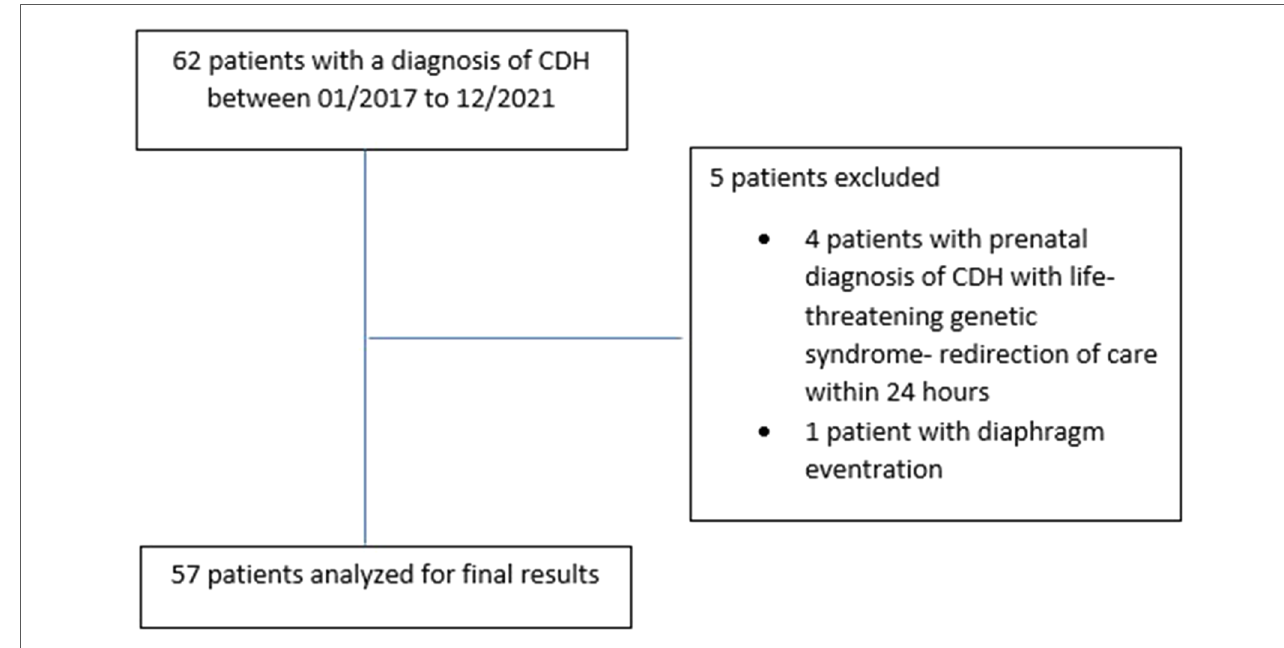
FIGURE 1 Study characteristics-inclusion and exclusion of